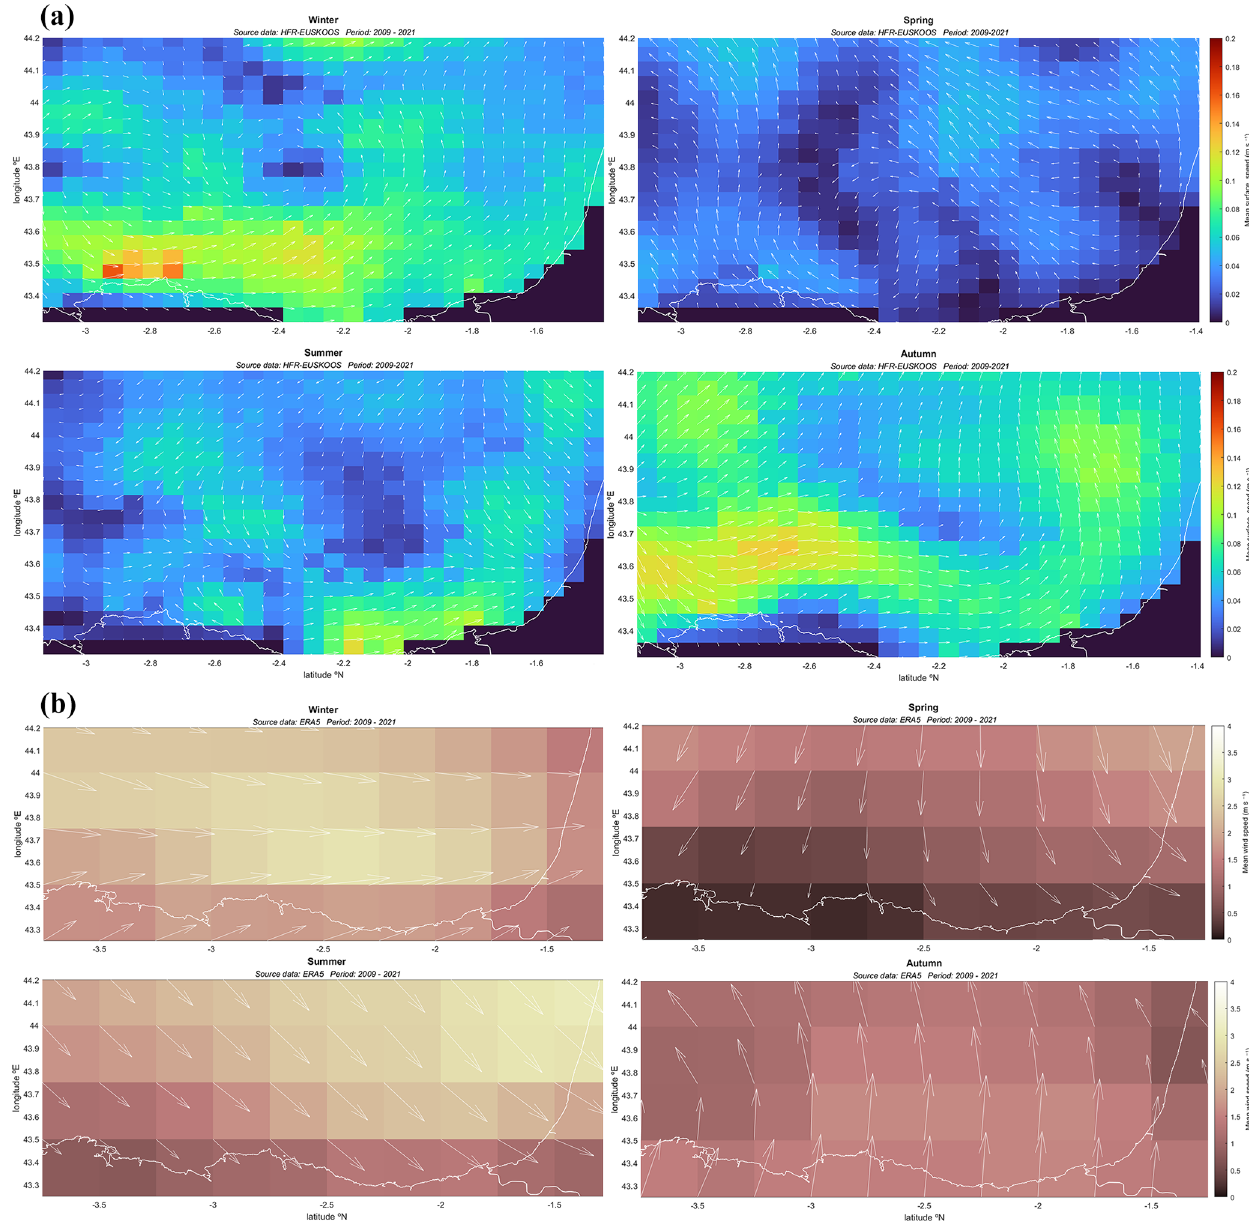
Figure D1. Mean current (a) and wind fields (b) in the study area during each season for the selected periods between 2009 and 2021. The colour bars represent the magnitude of current and wind speed. The arrows indicate the current and wind mean direction and are scaled with currents and wind speed (data sources: HF radar – EuskOOS, https://www.euskoos.eus/en/data/basque-ocean-meteorological-network/ high-frequency-coastal-radars/; ERA5, https://www.ecmwf.int/en/forecasts/datasets/reanalysis-datasets/era5, last access: 11 Novem- ber